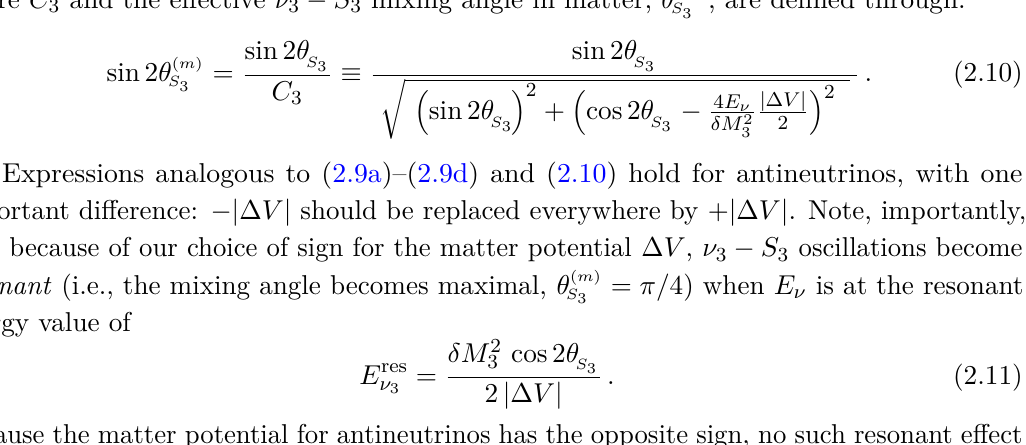
Figure 2 . The in-medium effective mixing angles θ ( m ) ¯ ν 3 − S 3 and ¯ ν 3 − S 3 , respectively. The dependence of these angles is shown as a function of (anti)neutrino energy E in units of the resonant energy E res ν mixing angle θ S 3